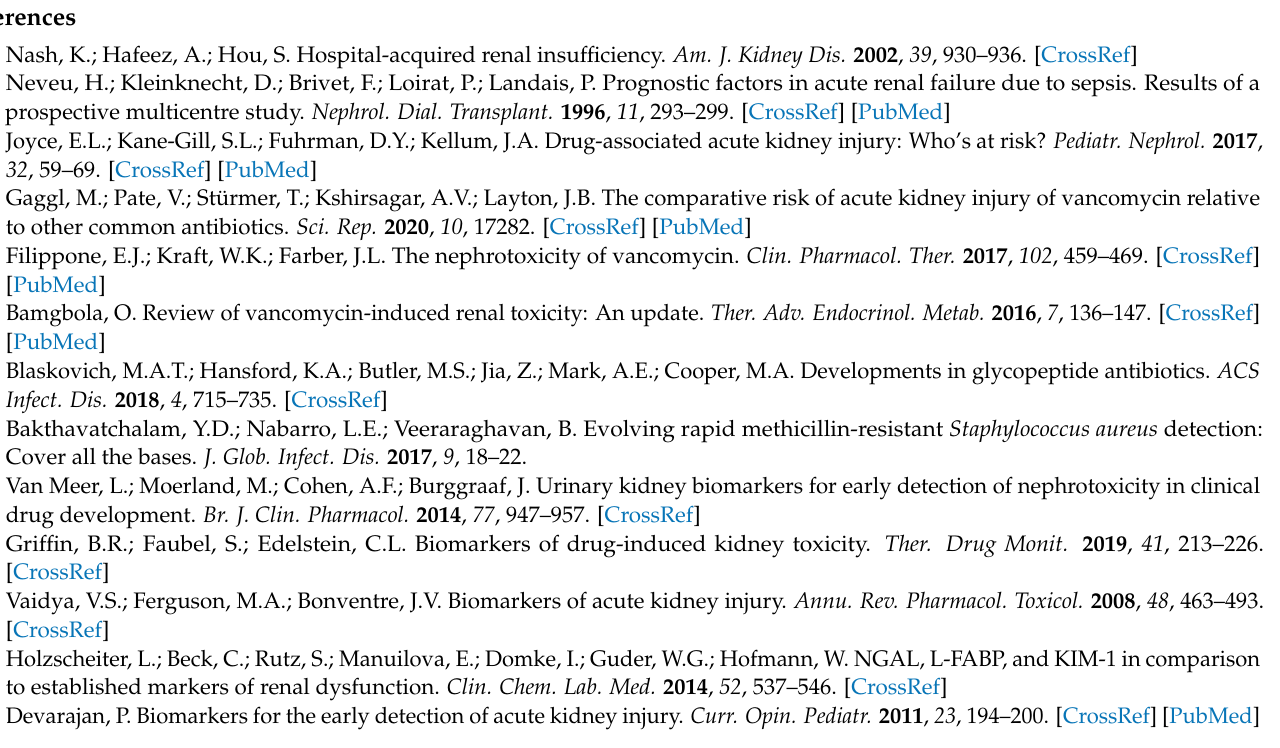
Table S2: Comparison of concentrations of serum amino acids and amino acid derivatives correlated with glomerular filtration rate between VAKI group and non-VAKI group; Table S3: Comparison of serum tryptophan, serotonin, and 5-HIAA concentrations from non-VAKI subgroups, including an infection subgroup, CKD subgroup, and healthy control